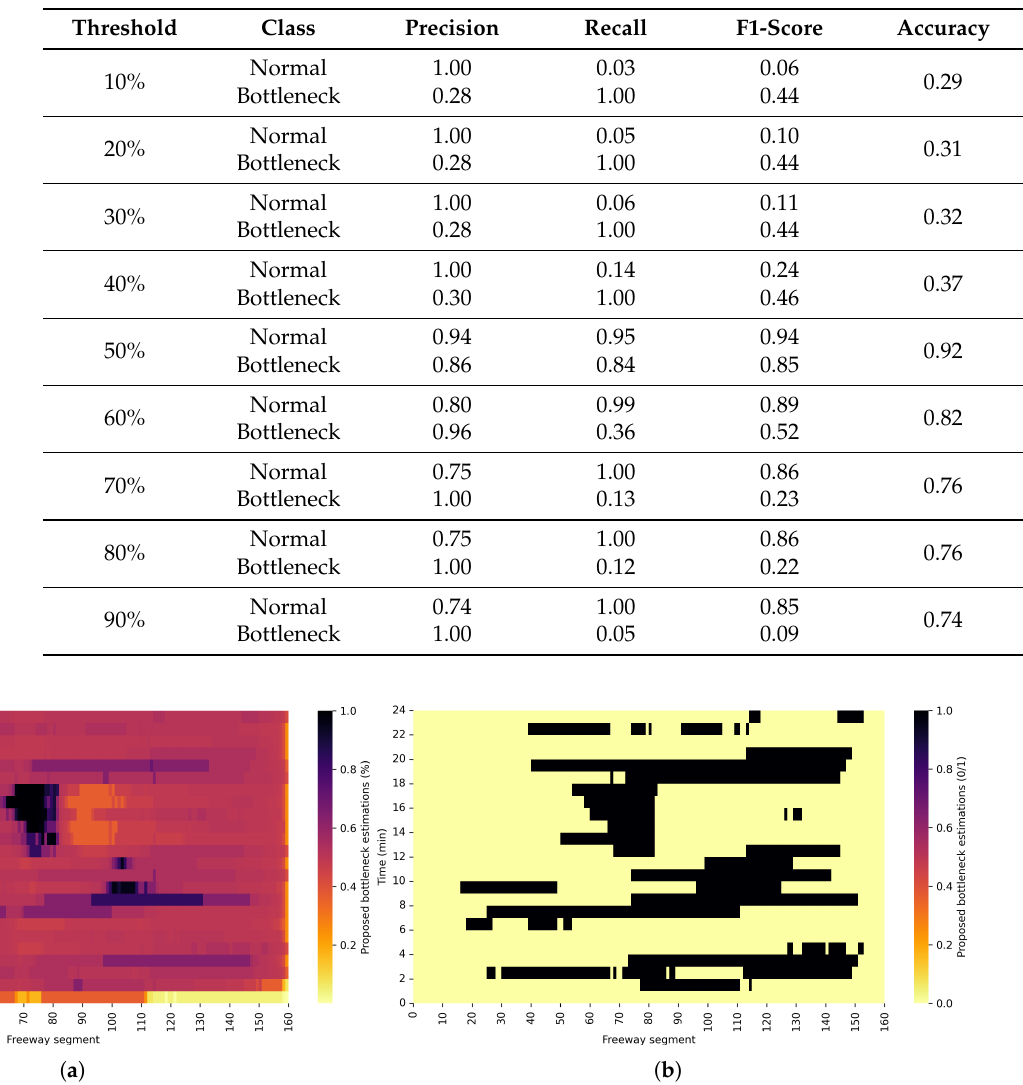
Table 3. Validation of the threshold for the proposed bottleneck probability estimation method.